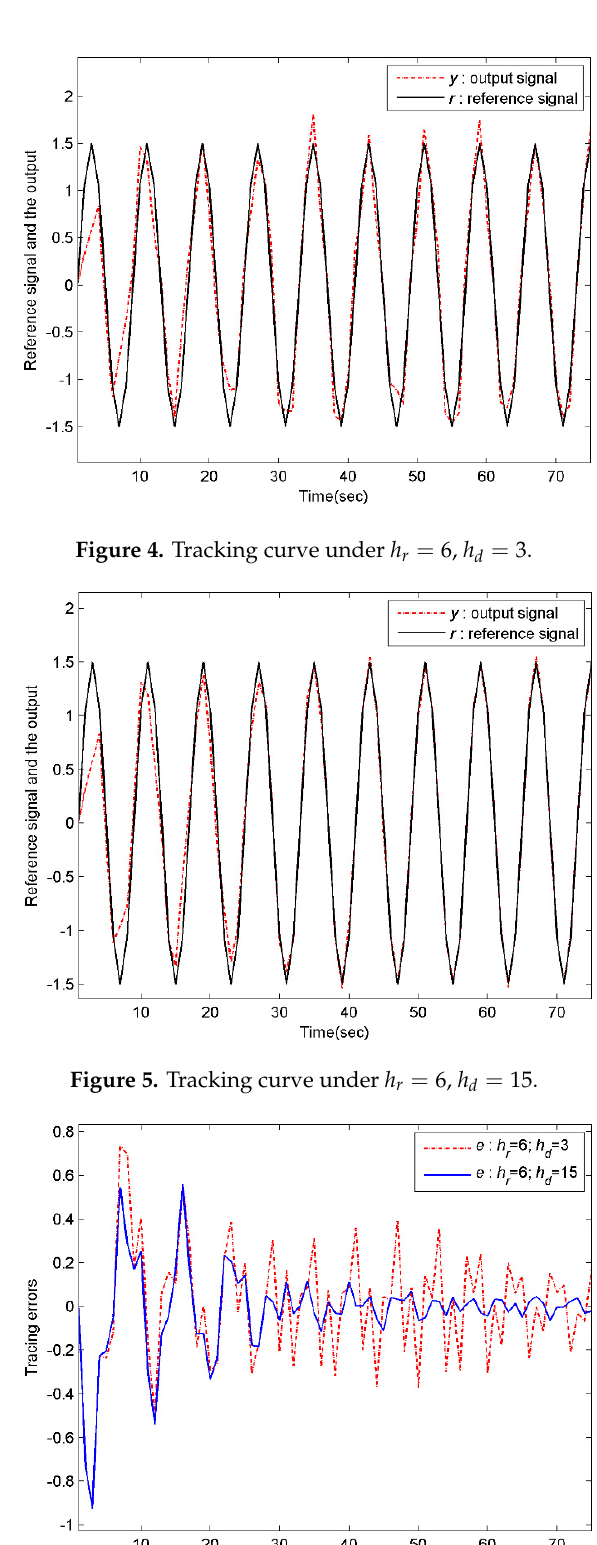
h h and different d .